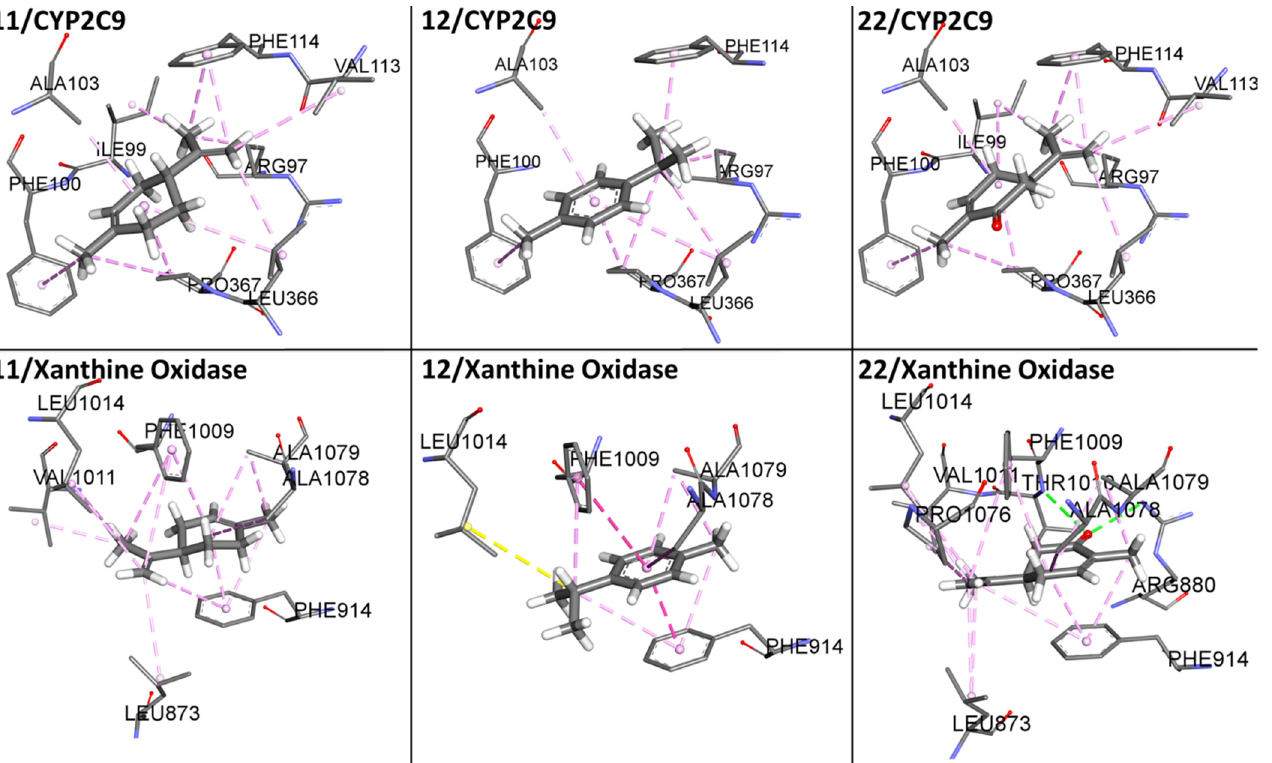
Figure 4. Schematic representation for the best three compounds ( 11 , 12, and 22 ) of the score normalization of the binding energy based on the number of non-hydrogen atoms of VPEO bound to CYP2C9 and xanthine oxidase. The surrounding amino acid residues in the binding pocket of CYP2C9 and xanthine oxidase within 3 Å are shown.